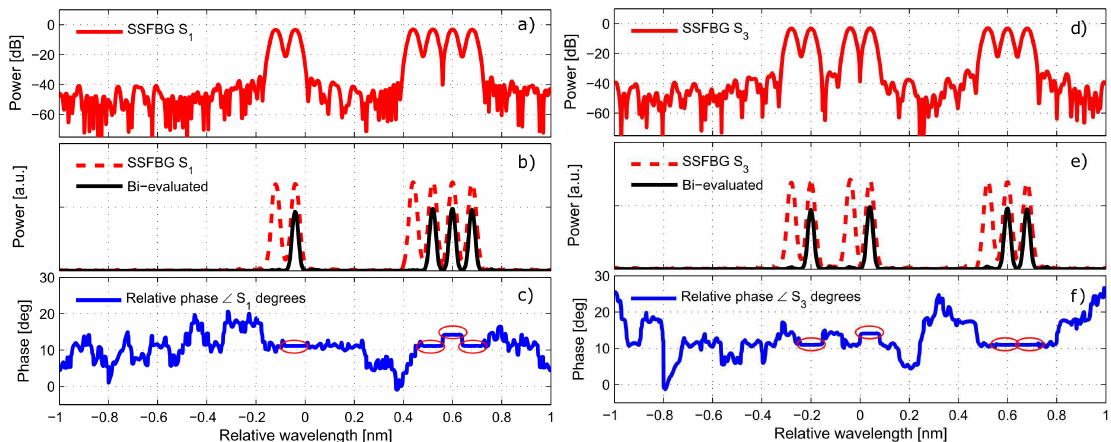
Figure 7. Design for the super-structured sensor S 1 and S 3 . ( a , d ) Represents the magnitude spectrum in dB for the first and third designed sensor; ( b , e ) the linear representation of the magnitude spectrum and their bi-evaluated shape; and ( c , f ) the relative phase of the devices S 1 , S 3 , i.e., the phase relationship between consecutive sub-bands of the